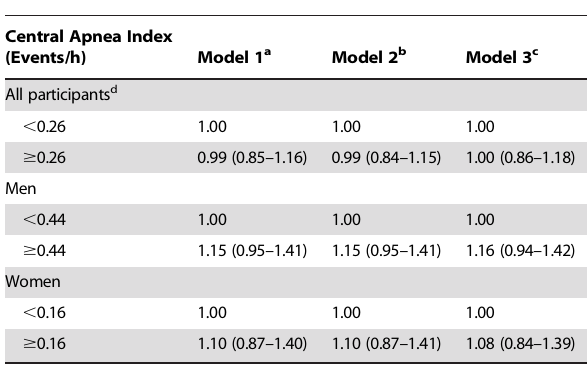
Table 5. Adjusted hazard ratios (95% confidence intervals) for the association between the central apnea index and all-cause mortality stratified by sex and age.